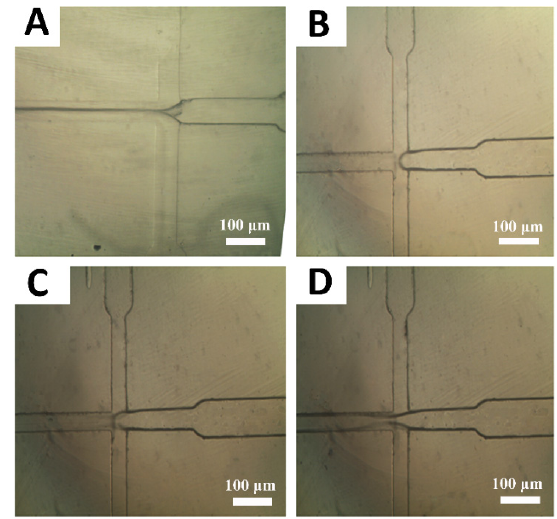
Figure 2. Effect of flow rates ratio (Q polymer /Q drug ) on the production of poly (lactic-co-glycolic) acid (PLGA) droplets: ( A ) 10, ( B ) 5, ( C ) 3.3 and ( D ) 2.5. To achieve these values, the drug flows in the middle channel were adjusted at 0.5 mL/h, 1 mL/h, 1.5 mL/h and 2 mL/h. Also, the polymer flow in the side channels was fixed at 5 mL/h.